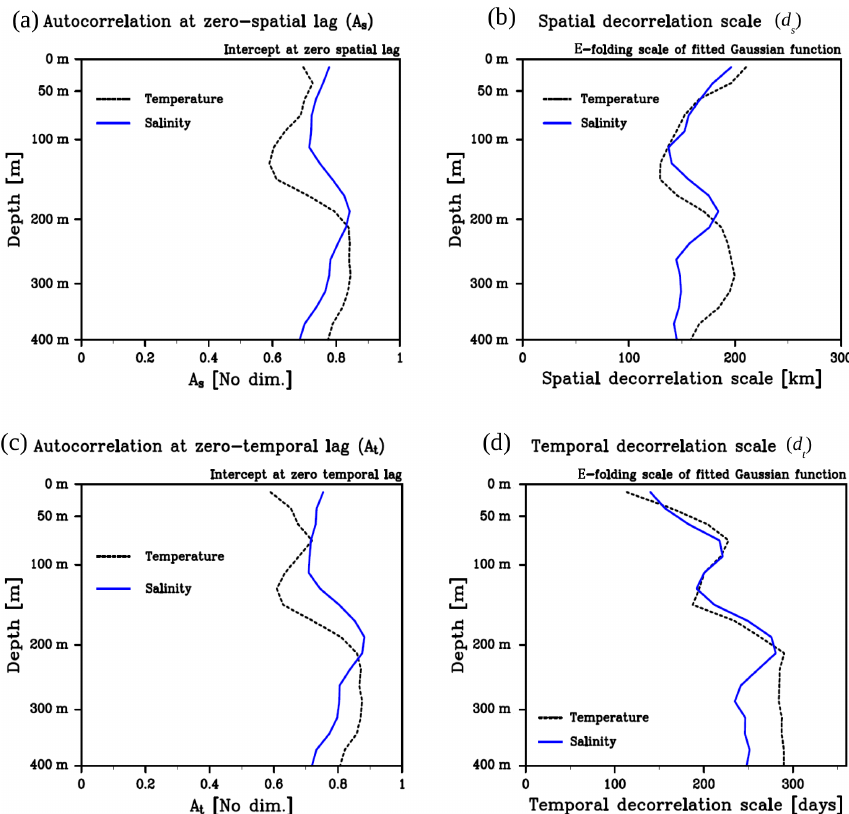
Figure 12. Vertical profiles of zero-lag autocorrelation (a, c) and e -folding scale (b, d) of the fitting spatial (a, b) and temporal (c, d) autocorrelation functions. A three-layer vertical filter is applied to eliminate noise.